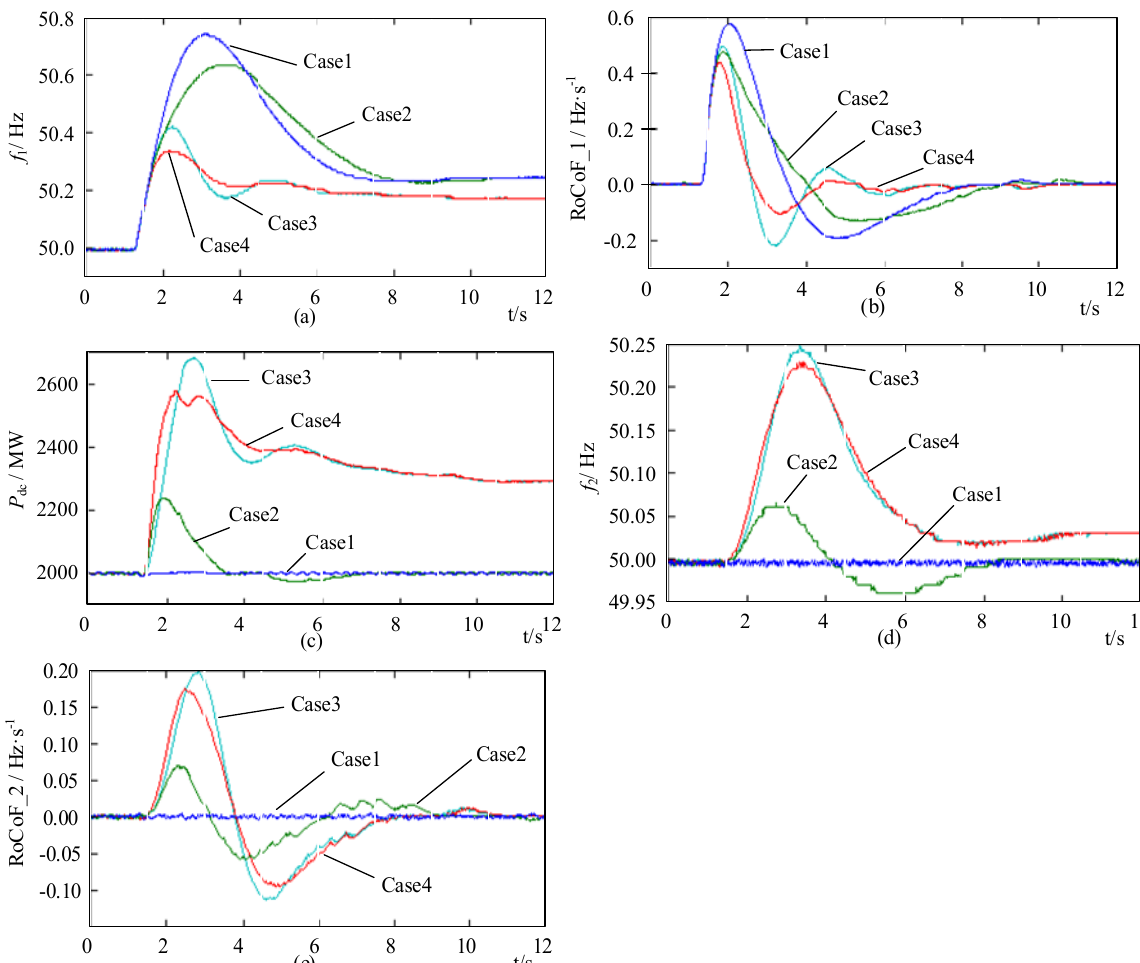
Figure 12. System frequency under different control modes (sudden load decrease). ( a ) the frequencies of the sending-end system; ( b ) the RoCoF of the sending-end system; ( c ) the actual power transmitted by the UHVDC; ( d ) the frequencies of the receiving-end system; ( e ) the RoCoF of the receiving-end system. In frequency coordinated control, R vir = 0.04 and H vir = 3.5 s. The droop control